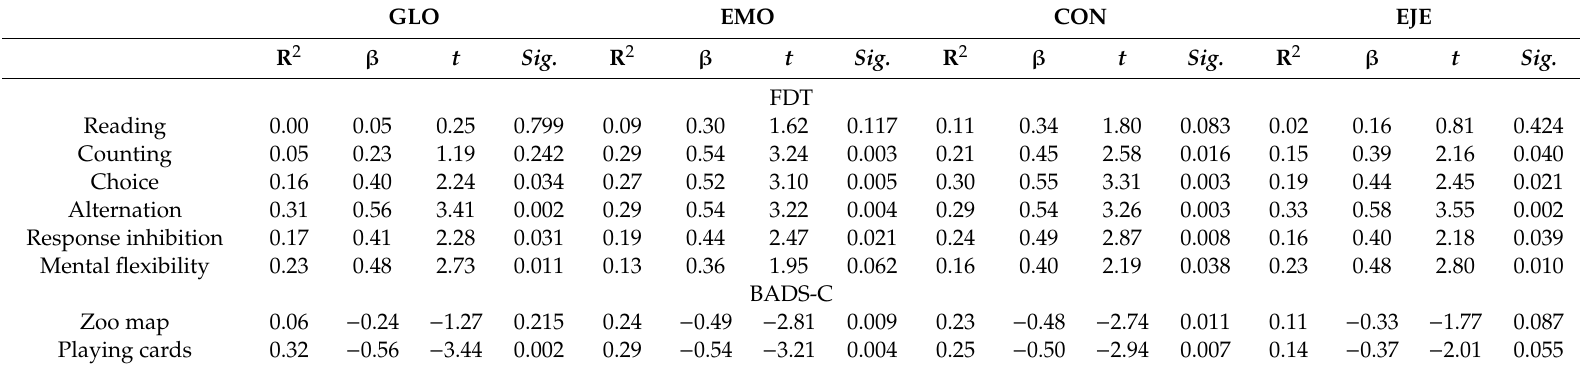
Table 4. Regression analysis between the emotional and behavioural problems and the executive